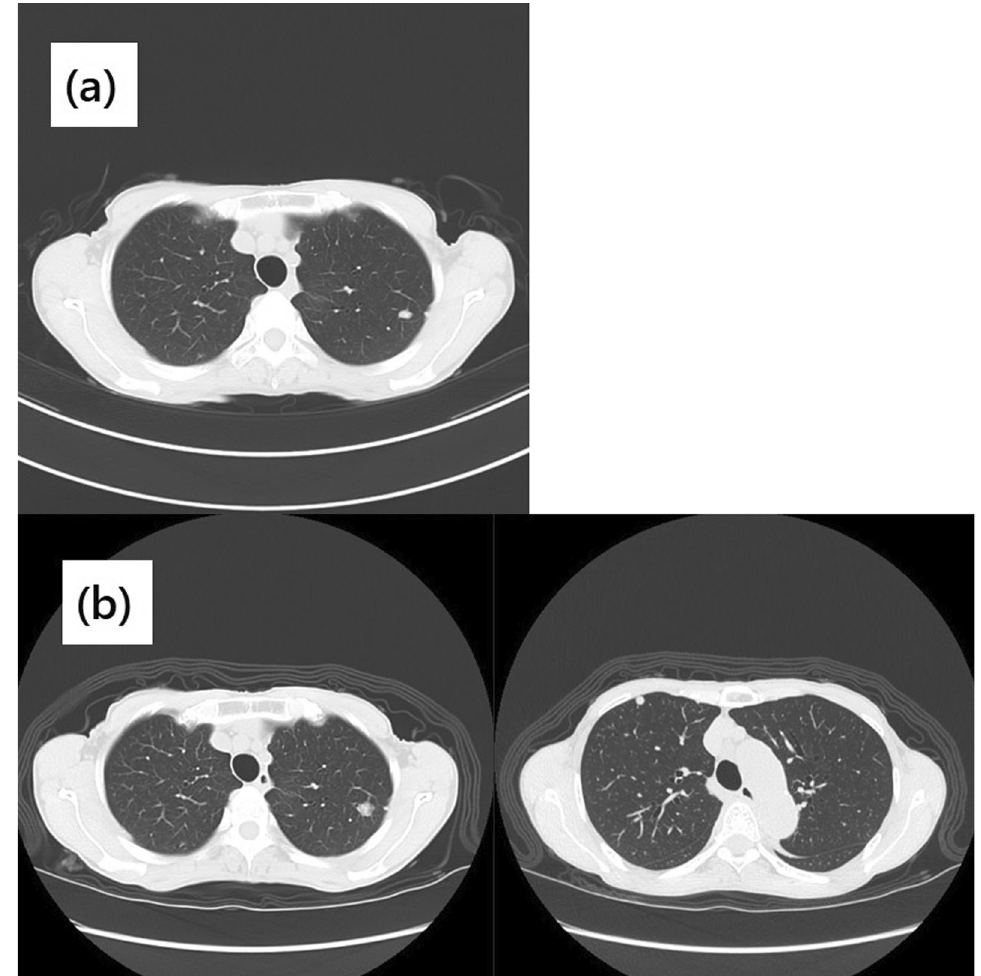
Fig. 4 Computed tomography showing a pulmonary nodule. a 22 months after surgery; b 25 months after